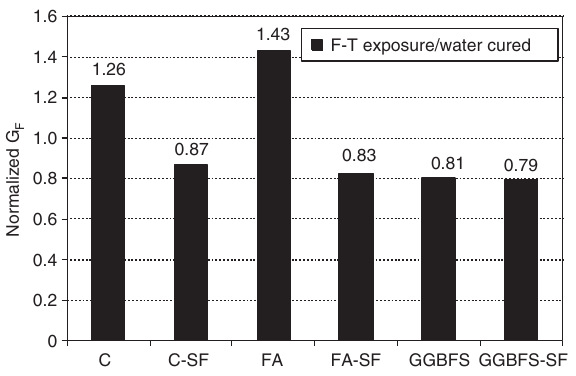
Figure 11 Normalized fracture energy after F-T exposure compared to the fracture energy of water-cured